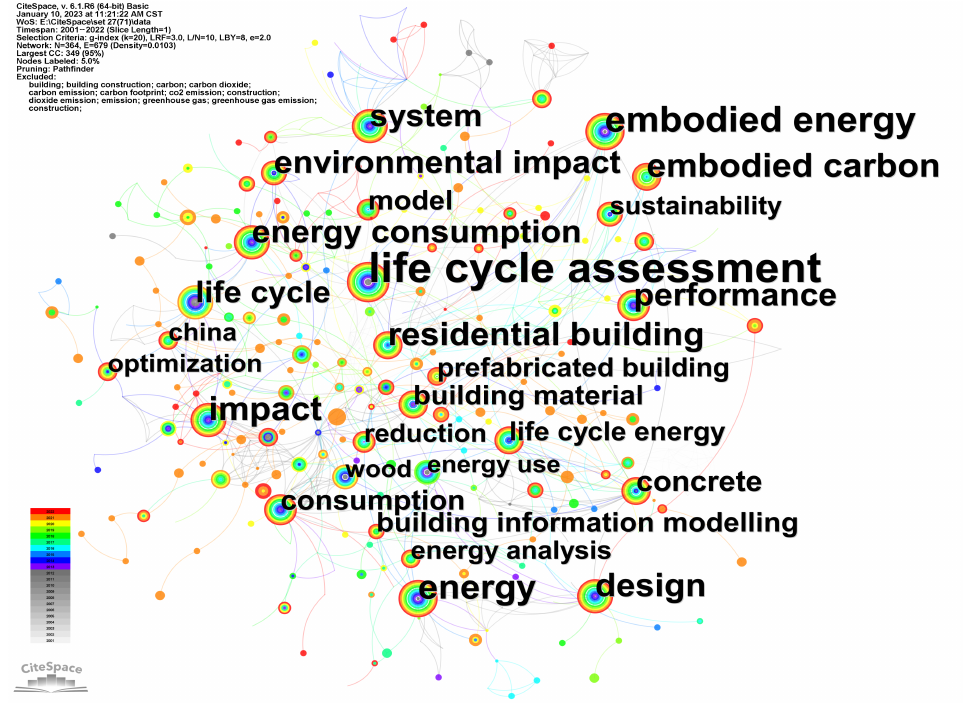
Figure 4. Keywords co-occurrence